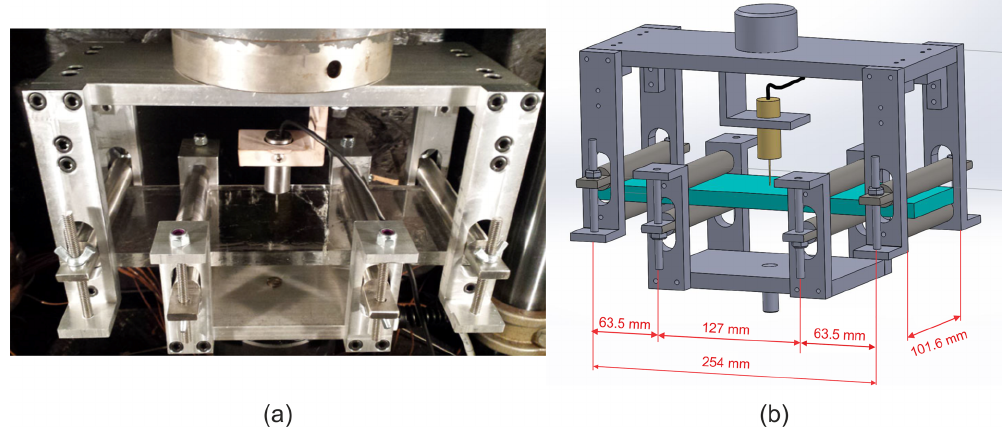
Figure 5. Photograph (a) and sketch (b) of the four-point bending apparatus connected to an MTS hydraulic testing system (Iliescu et al., 2017; Murdza et al., 2020b). The upper part is attached to the frame of the machine while the mobile middle part is attached through a fatigue-rated load cell to the piston. The apparatus is made from an aluminum alloy; the loading cylinders are made from stainless steel.